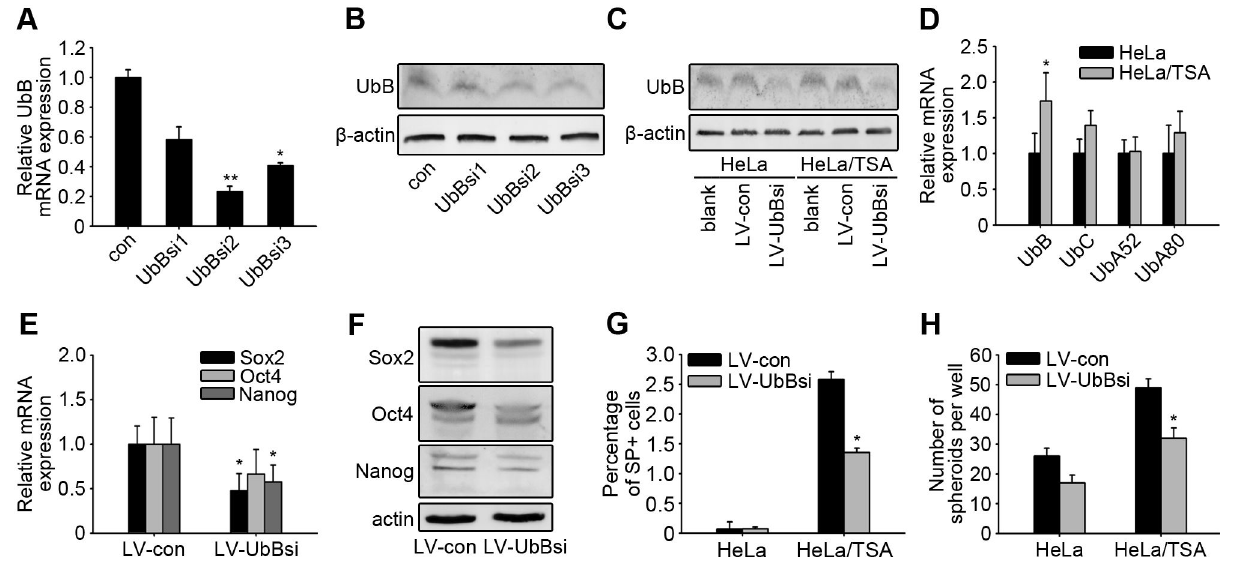
Figure 4. UbB siRNA could down-regulate the SP and spheroids formation. A , HeLa cells were transfected with 10 nM UbB- targeting siRNA, or stealth RNAi control, for 72 hours. Real-time PCR analysis of relative UbB mRNA expression was proceeded. GAPDH was used as a reference control. B , The quantitative analysis of the UbB protein level by western blotting. Cells were treated as described in A. Beta-actin was used as a reference control. C , HeLa and HeLa/TSA mammosphere cells were infected with LV-UbBsi, which was cloned with UbBsi2, for 72 hours and subjected to analysis by western blotting for UbB protein level. D , LV-UbBsi-infected mammosphere cells were analyzed for the UbB, UbC, UbA52 and UbA80 mRNA levels. GAPDH was used as a reference control. The columns represent the average of three separate experiments; error bars, SD. E , LV-UbBsi-infected HeLa/TSA mammosphere cells were analyzed for the Sox2, Oct4 and Nanog mRNA levels. GAPDH was used as a reference control. The columns represent the average of three separate experiments; error bars, SD. F . LV-UbBsi-infected HeLa/TSA mammosphere cells were analyzed for the Sox2, Oct4 and Nanog protein levels. Beta-actin was used as a reference control. G , The analysis of the side-population cell fraction in LV-UbBsi-infected HeLa and HeLa/TSA cell cultures. H , The spheroid formation assays were performed on LV-UbBsi-infected